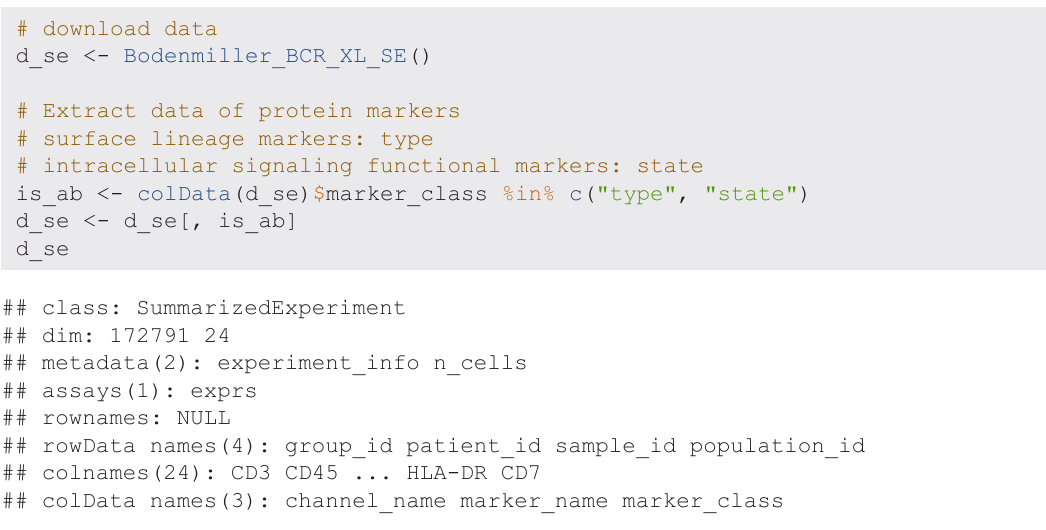
We preprocess the data and cluster cells using the workflow from the diffcyt package 21,22 . According to the median expressions of lineage markers per cluster, a tree cytof_hclust is then constructed by applying the hierarchical clustering on the cell cluster level, using only the “type”